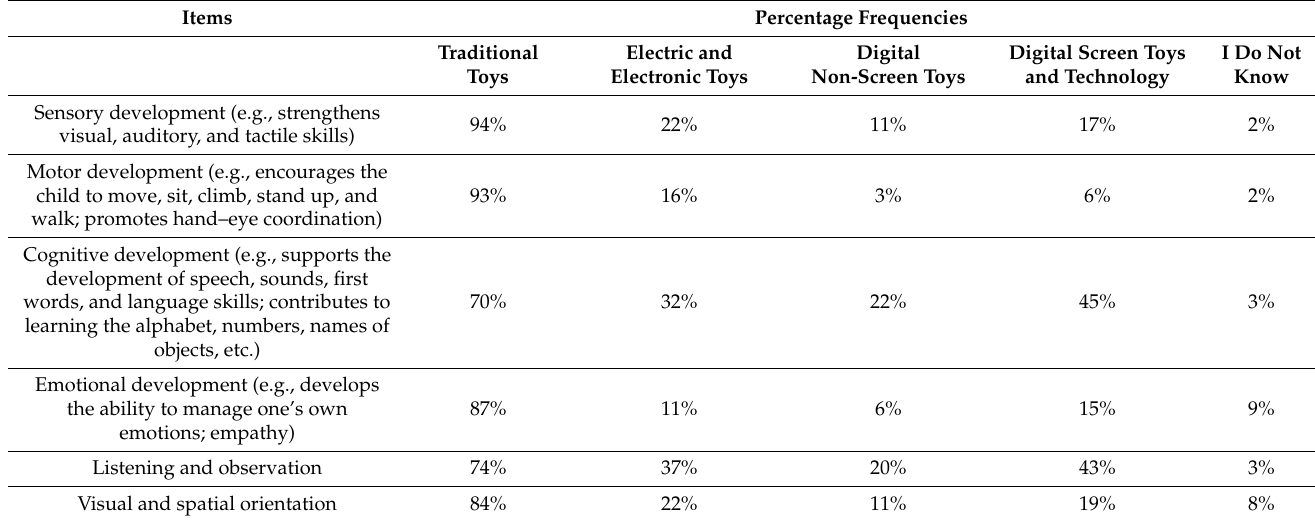
Table 3. Children’s learning and development in play—analogue vs.